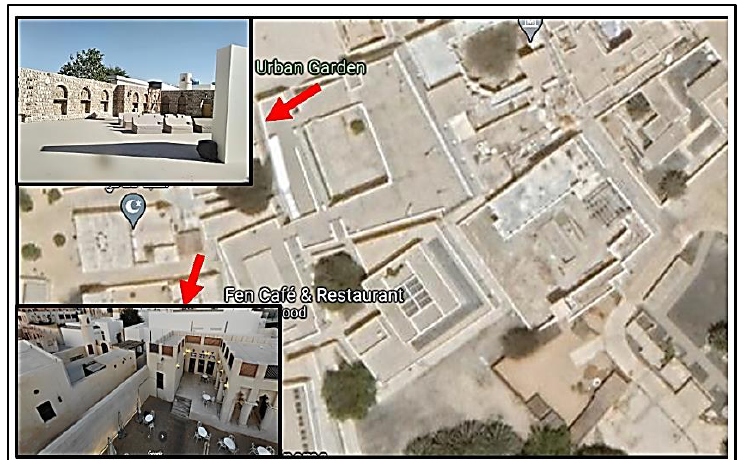
Figure 5. Old district — Al Marijah, Sharjah, UAE [48]